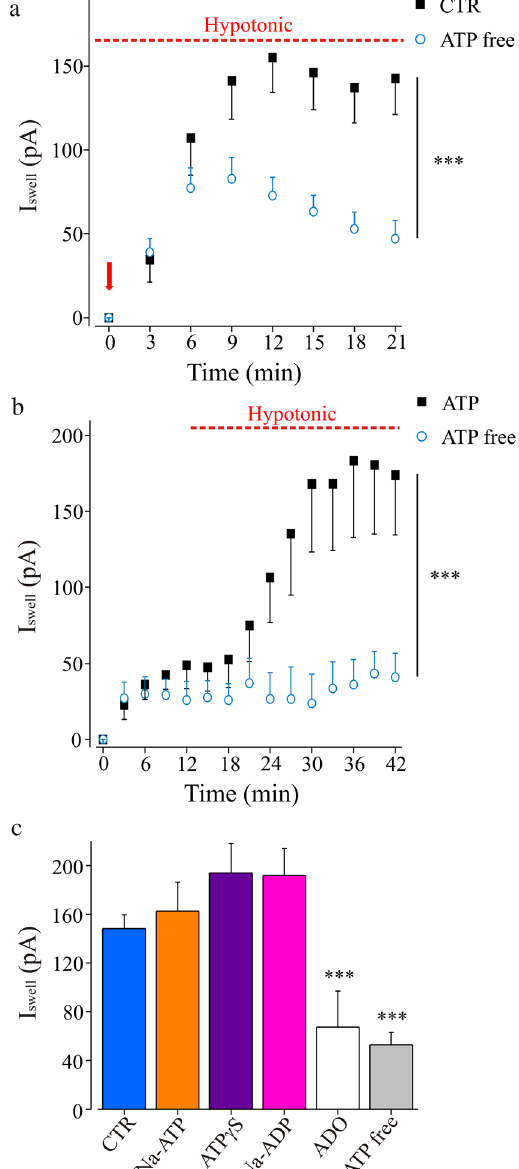
Figure 3. Microglia swelling currents activation requires intracellular purines. ( a ) Time course of I swell recorded with control pipette solution (2 mM Mg-ATP, n = 18; black) or with an ATP-free solution (n = 27; cyan; *** p = 0.001, two-way ANOVA, Holm-Sidak) under chronic hypotonic stimulation. (b) Time course of the swell-activated current evoked by acute application of hypotonic stimulus, in the presence of 2 mM Mg-ATP (black, n = 5) or without Mg-ATP (cyan, n = 6) in the intracellular solution. *** p = 0.001, two-way ANOVA, Holm-Sidak. Notice that after complete intracellular dialysis, I Swell is absent when ATP was omitted from pipette solution. ( c ) Bar chart representing swell-activated current amplitude (18 minutes after hypotonic stimulation; MP = + 50 mV) recorded with substitutions of Mg-ATP (2 mM) in the pipette solution. Each experimental set was compared with respective internal controls (recorded in the same experimental days with Mg-ATP in the pipette solution). CTR bar represents mean I Swell amplitude of all internal controls (2 mM Mg-ATP in the pipette solution, n = 48; blue bar). Na-ATP (2 mM, orange; n = 7 vs n = 10; p > 0.05, t-test), ATP γ S (2 mM, violet; n = 11 vs n = 6; p > 0.05, t-test), Na-ADP (2 mM, pink; n = 12 vs n = 15; p > 0.05, t-test), adenosine (ADO, 2 mM, white; n = 10 vs n = 18; *** , p < 0.001, t-test) or with an ATP-free solution (gray; n = 23 vs n = 17; *** , p < 0.001,